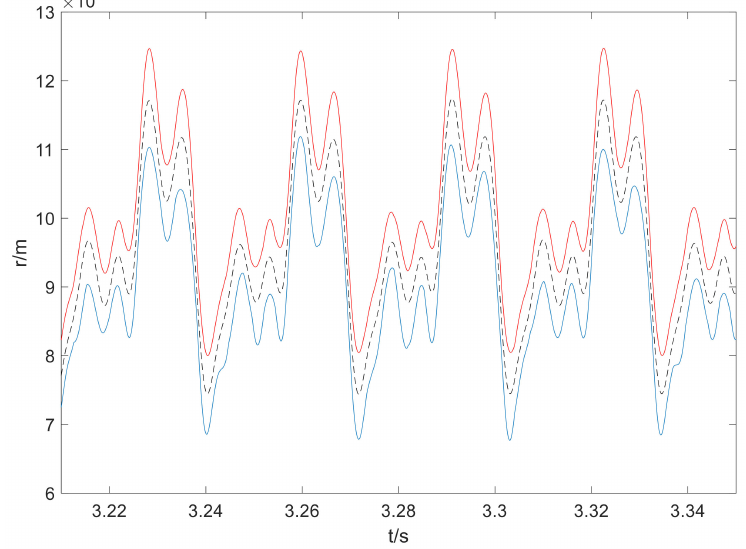
Figure 11. Vibrations of the rubbing rotor at ω = 200 rad/s with three bounded uncertainties: blue solid line = lower bound; red solid line = upper bound; black dotted line = deterministic